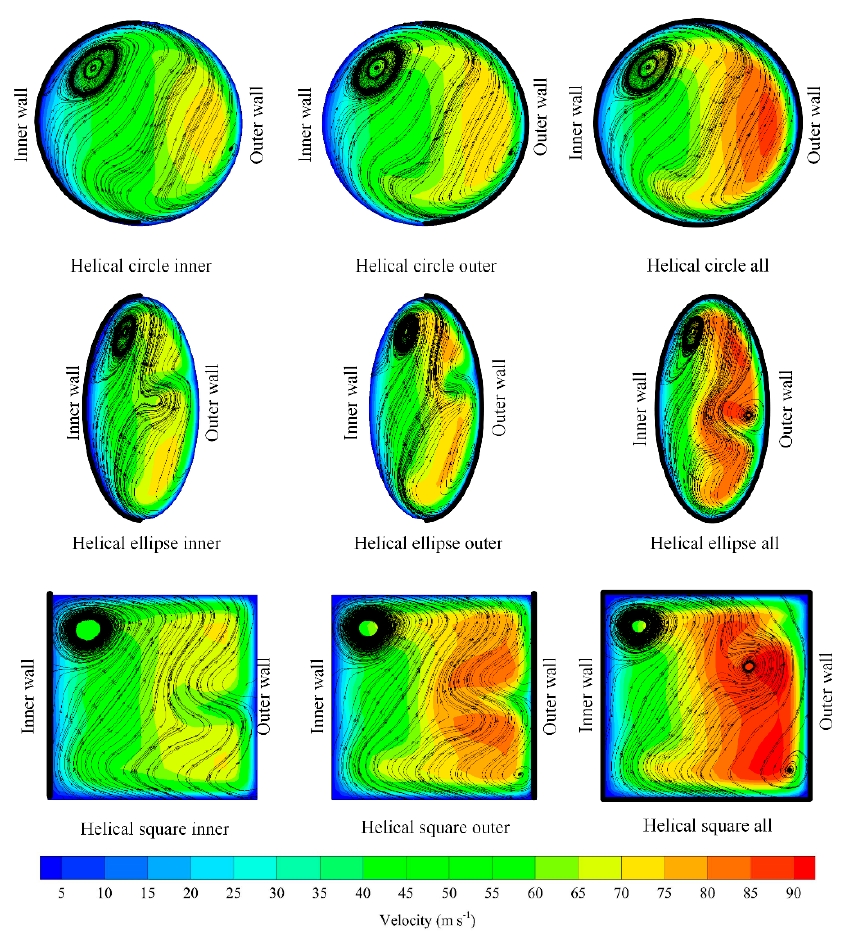
Figure 8. Axial velocity profile (contour, m s − 1 ) and streamlines of flow in helical reactors with various cross-sections and coating strategies at L = 31 cm and Reynolds number of 1000. The coated walls are highlighted in black line.